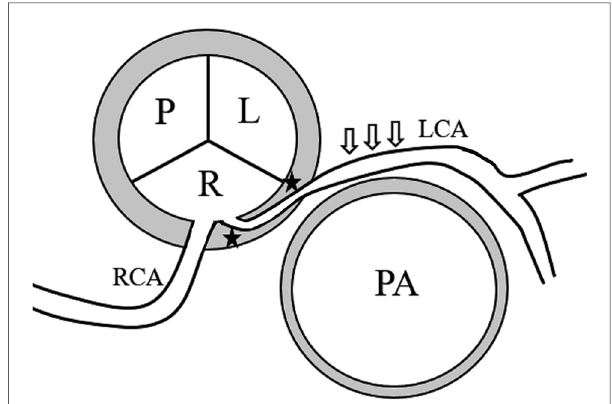
FIGURE 1 Intermural and inter-arterial course pattern diagram. The anomalous left coronary artery (LCA) from the right coronary sinus with intermural (black star) and interarterial (open arrows)